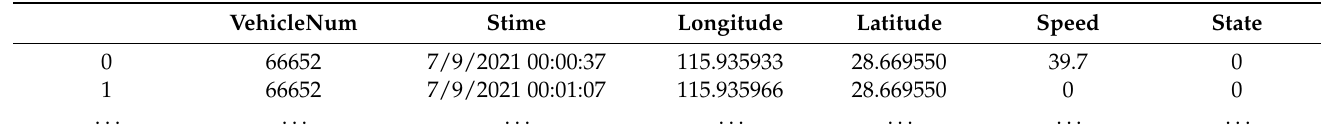
Table 2. Sample of trajectory data after data cleaning.